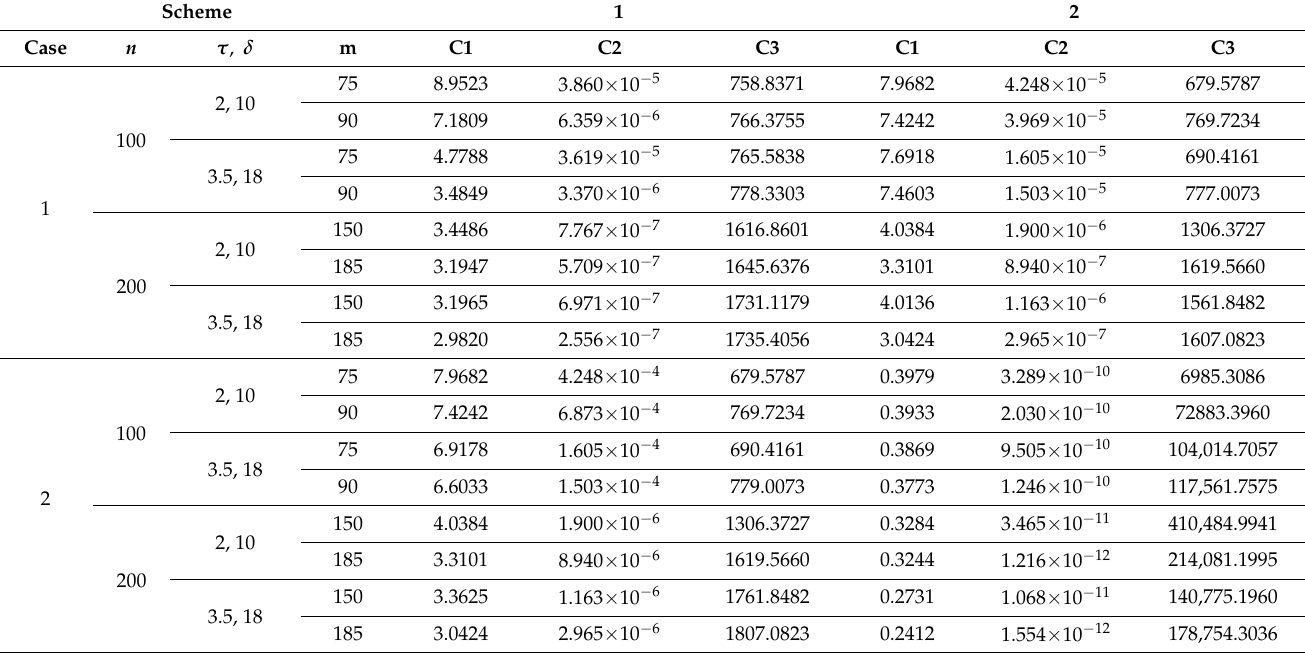
Table 6. Optimization criterion with different schemes and cases.